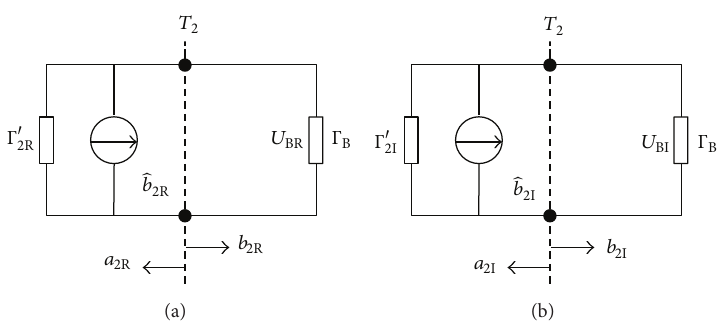
Figure 9: The further simplified circuit models for (a) radiation test and (b) injection